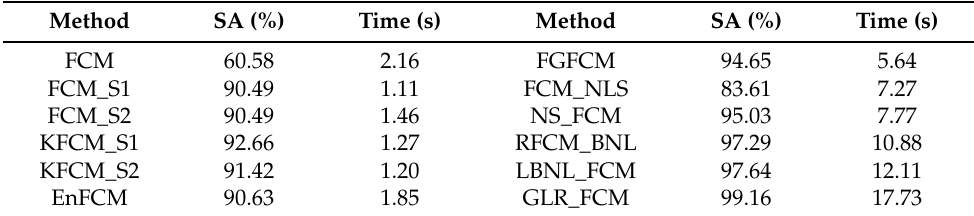
Table 2. SA (%) and executed time(s) on the first simulated SAR